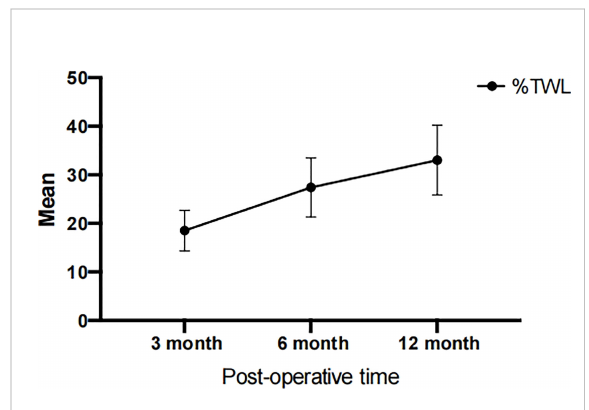
FIGURE 1 Postoperative %TWL at 3, 6, and 12 months. TWL, Total weight